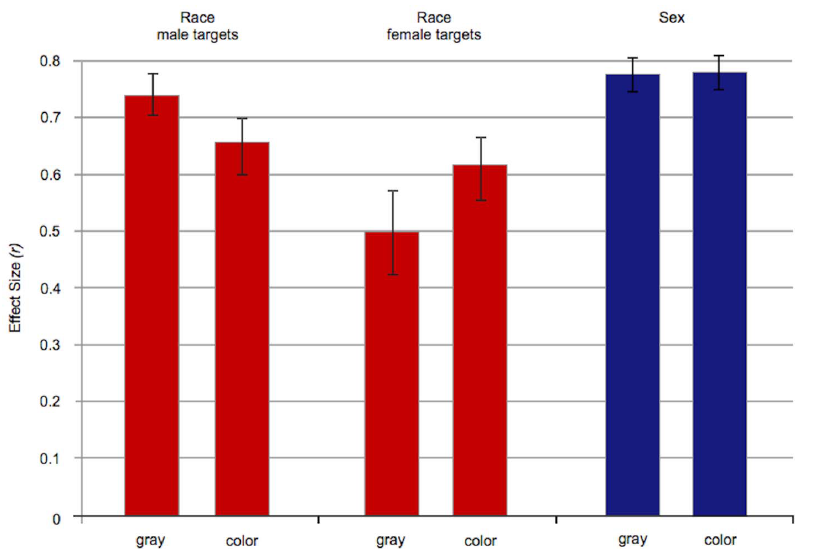
Figure 1. When coalitions are absent: Effect sizes for categorization by race (Study 1) and gender (Study 2). Racial categorization was same when race was the only visually distinct category (gray conditions) and when it was crossed with a vivid difference in shirt colors (color conditions). The same was true for gender categorization. Crossing race with a second category—one unrelated to coalitions—does not decrease racial categorization. (The same is true for gender categorization.) Error bars: + / 2 1 S.E. of mean error